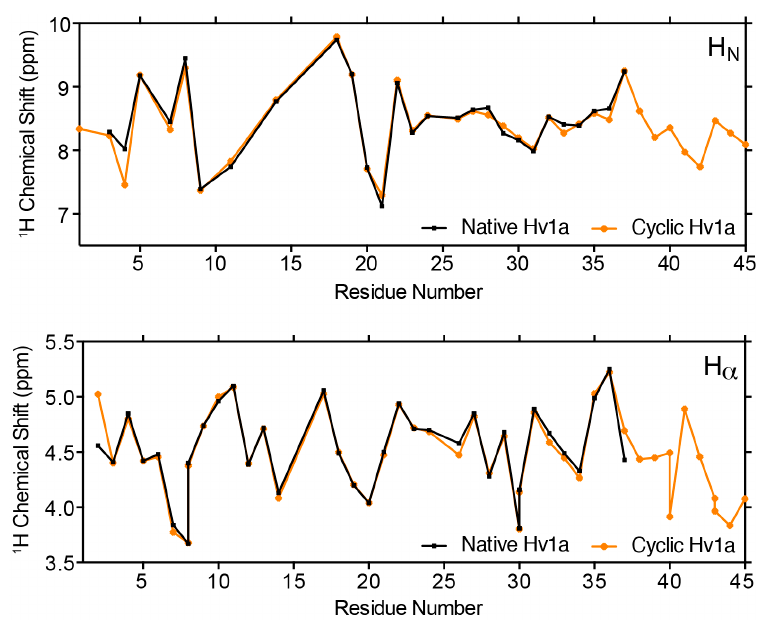
Figure 3. Comparison of the H N ( top ) and H α chemical shifts ( bottom ) of cyclic and native Hv1a.